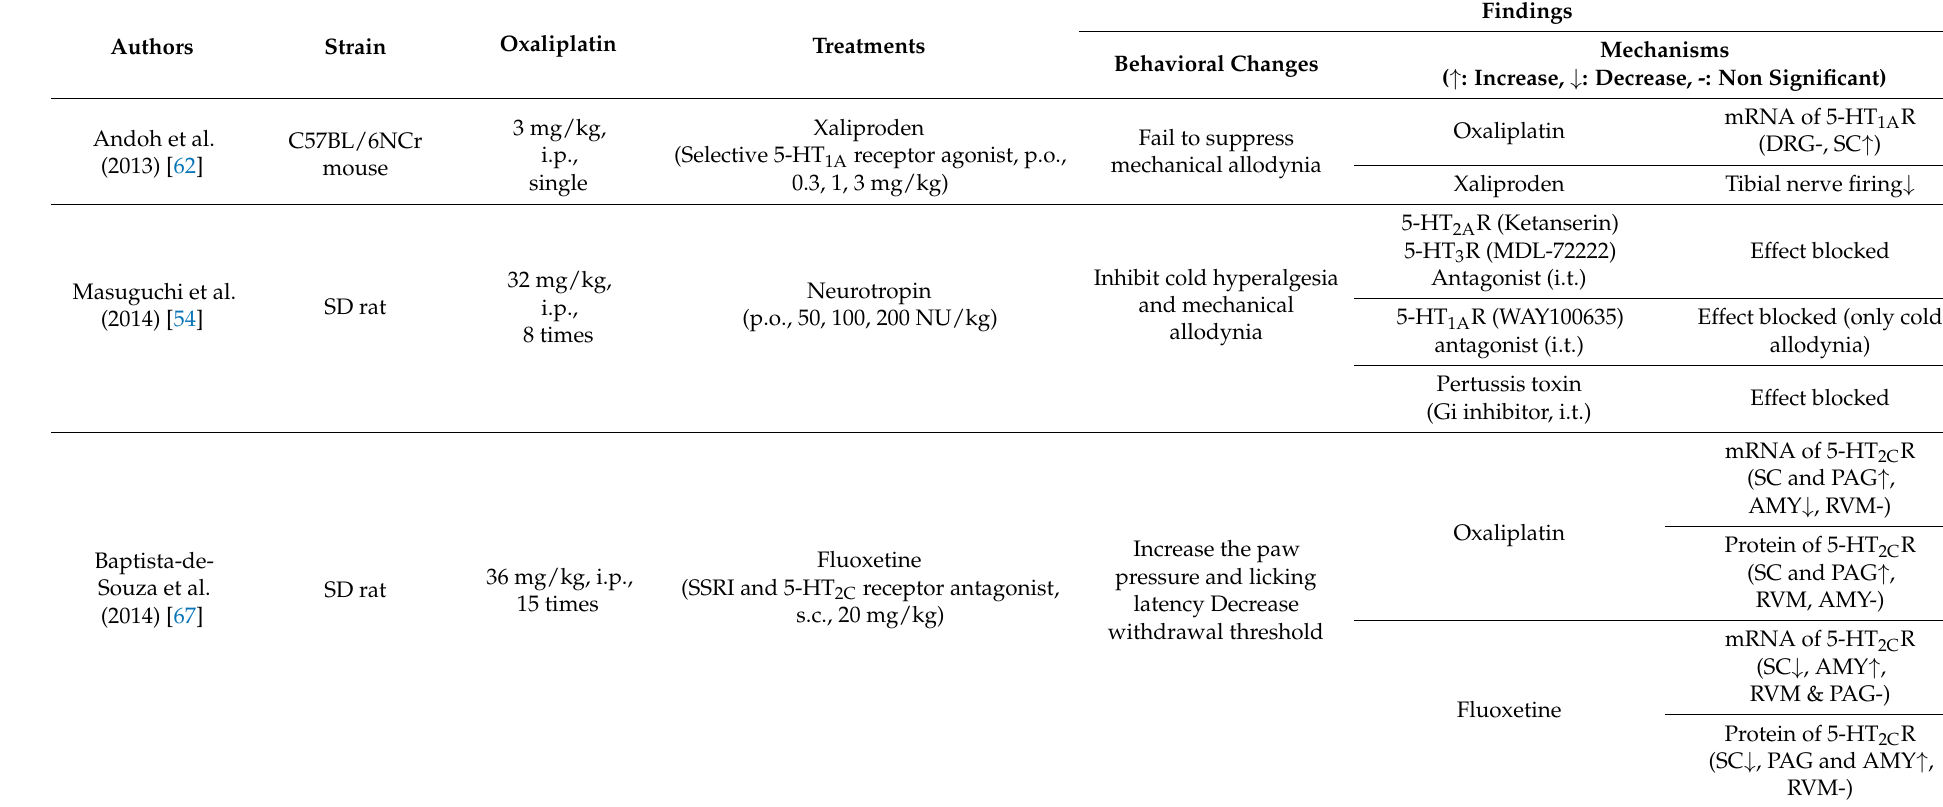
Table 2. The role of 5-HT receptors in oxaliplatin-induced neuropathic